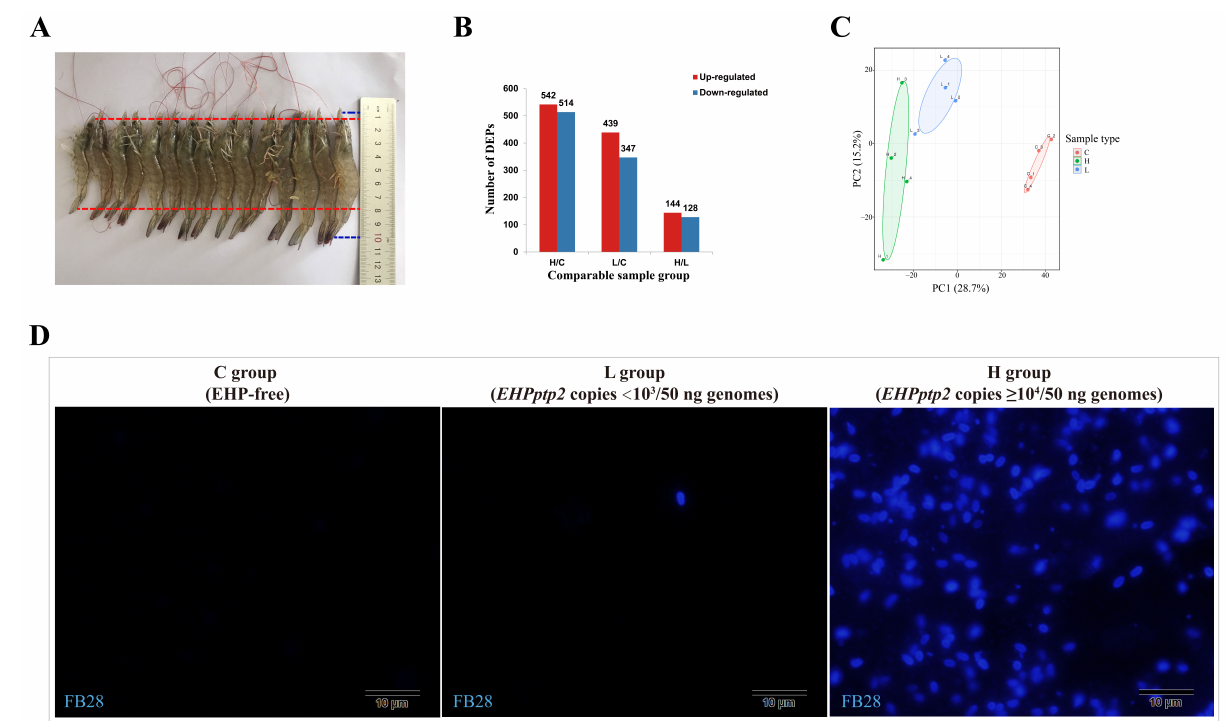
Figure 1. Sample information and basic statistics of proteomic data. ( A ): Shrimps in the pathogenetic pond presented various sizes. The large ones reached 10 cm (blue dotted line), while the little ones were less than 8 cm (red dotted line). ( B ): Summary of differentially expressed proteins, and the up- and down-regulated numbers were represented with red and blue columns, respectively. ( C ): PCA analysis was used to assess the repeatability of samples. ( D ): Shrimp samples were divided into three groups based on EHP load quantified by EHPptp2 RT-qPCR. The EHP quantity of each group was more intuitive by fluorescence microscopy, as the fluorescent brightener 28 (FB28) could label the spore wall of EHP. Each blue, fluorescent spot represented an EHP